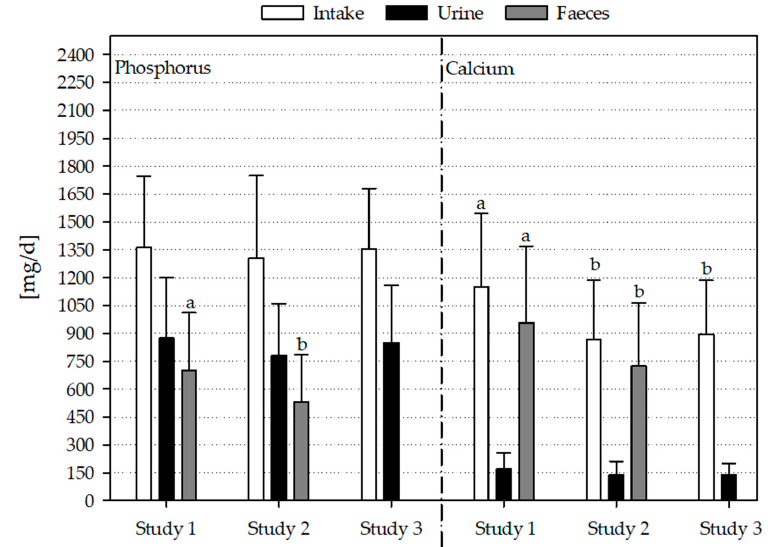
Figure 1. Habitual intake, renal and fecal excretion of phosphorus and calcium in three studies; n = 31 (Study 1); n = 56 (Study 2); n = 62 (Study 3); data are expressed as mean + standard deviation; a,b dissimilar superscript letters indicate significant differences between the studies; results without superscript letters are not significantly different; differences between the studies were tested with univariate analysis of variance followed by Bonferroni post hoc